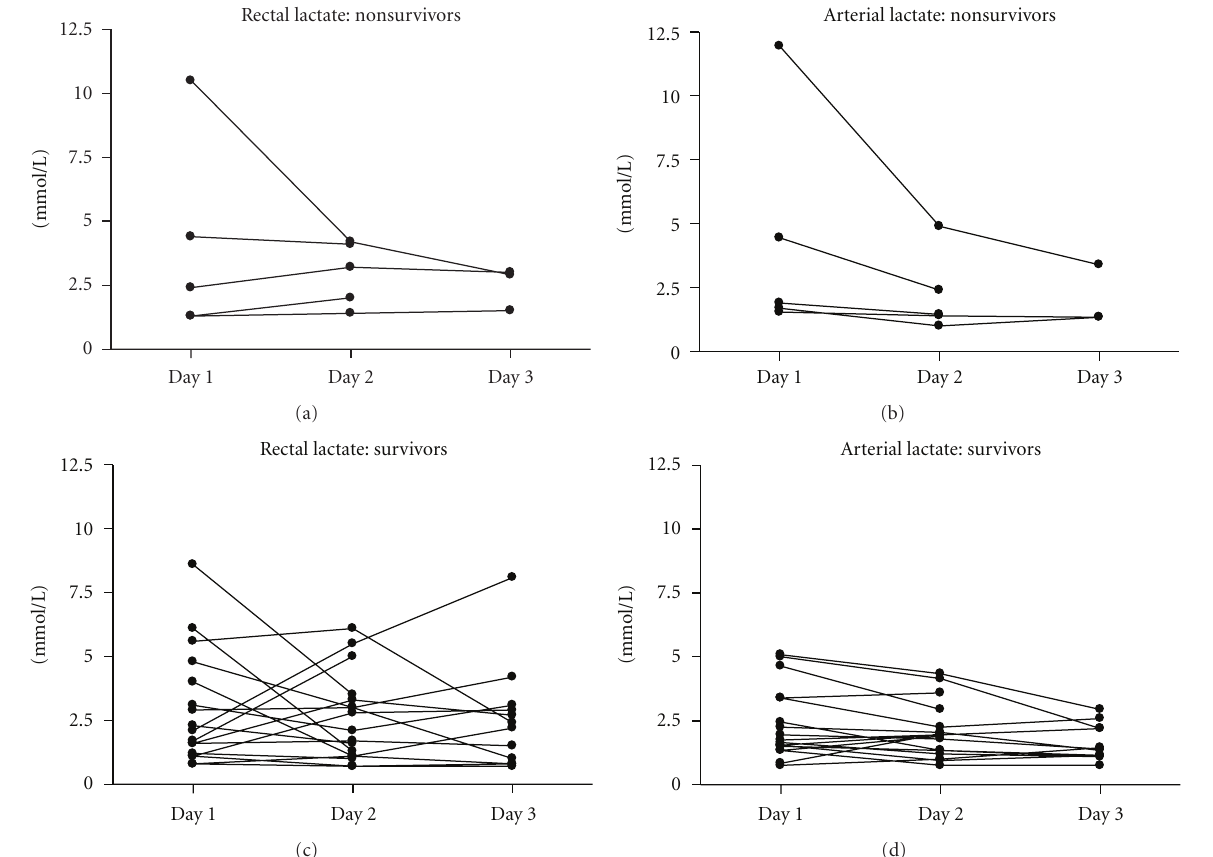
Figure 1: Rectal luminal and arterial concentrations of lactate in nonsurvivors and survivors of septic shock. There was no significant di ff erence between the groups on any day (Mann-Whitney test) or within the groups over the days (Wilcoxon’s signed rank test or Friedman test comparing paired values within groups over 2 or 3 days, resp.). See also Table 2 and